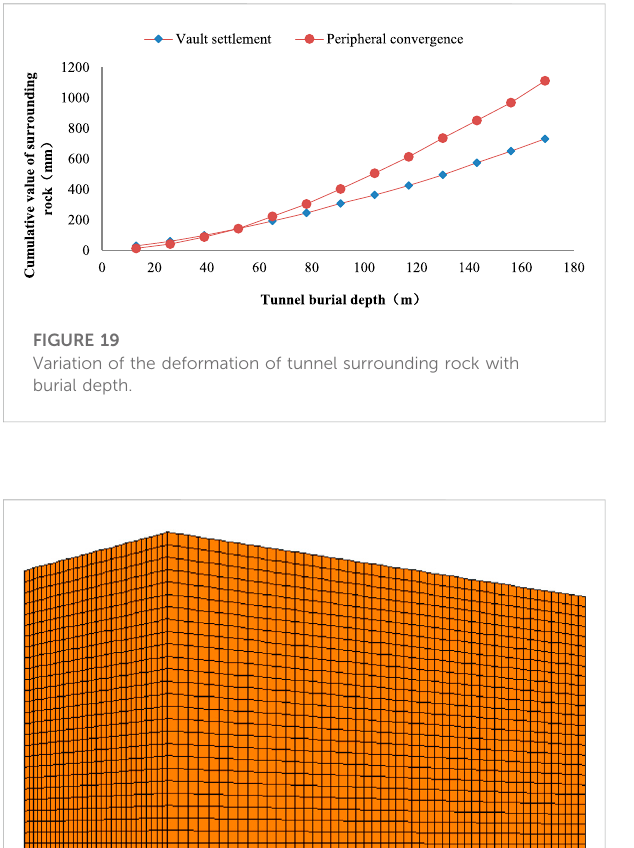
FIGURE 22 Variation pattern of the vault settlement of the surrounding rock with distance from the tunnel